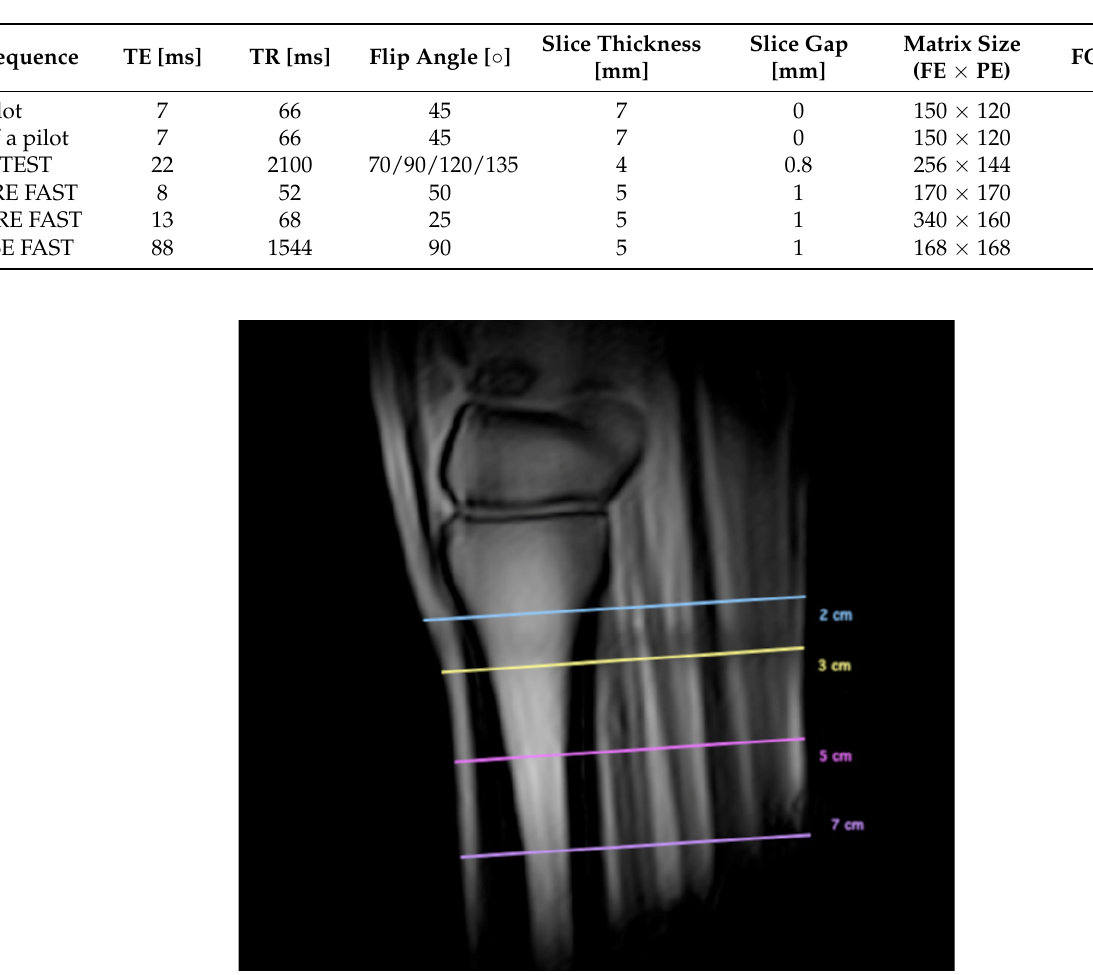
Figure 3. Transverse low-field T1-weighted gradient echo magnetic resonance images of a novice endurance horse ( A ) and an experienced endurance horse ( B ), obtained 3 cm distal to the carpomet- acarpal joint. Medial is to the left and dorsal is to the top. (ML) mediolateral width, (DP) dorsopal- mar depth, and (25, 50, 75%) palmar cortical thickness from medial to lateral. 2.2. Data Analysis A repeatability study was performed by IL on a sample of 10 limbs of the first five horses for which images were acquired. Three measurements were obtained for each pa- rameter, and the coefficient of variance was calculated using Microsoft Excel. The repeat- ability of measurements was confirmed (coefficient of variance ≤ 2%) before acquiring the study measurements.